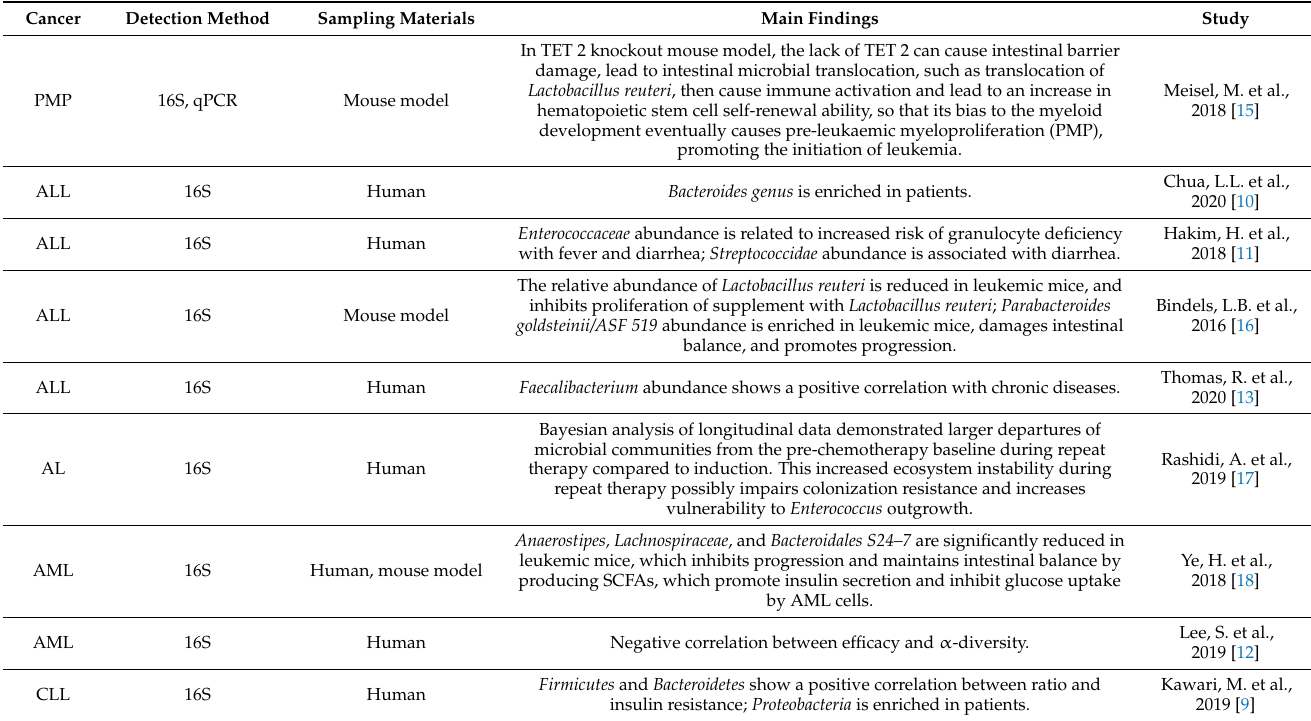
Table 1. Relationship between intestinal microbes and